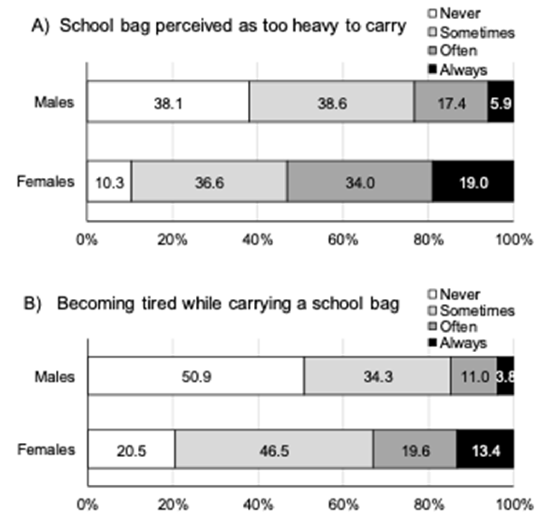
Figure 2. Adolescents’ perceptions of their school bag weight and effects on becoming tired.